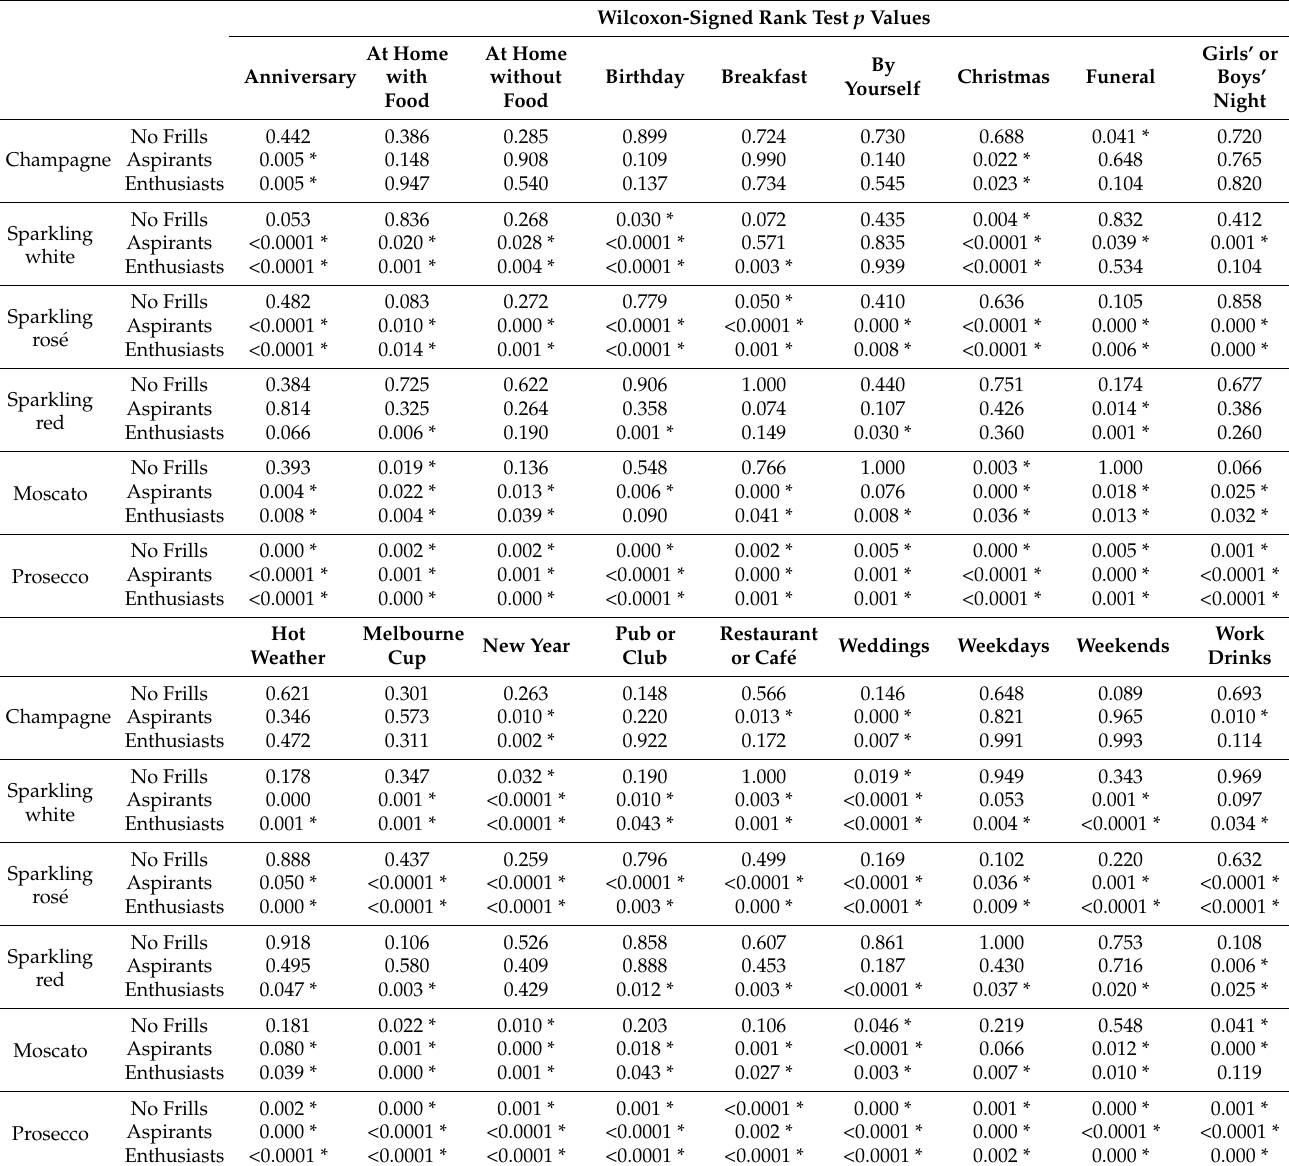
Table 10. Comparison of Fine Wine Instrument consumer segment preferences for different sparkling wine styles by